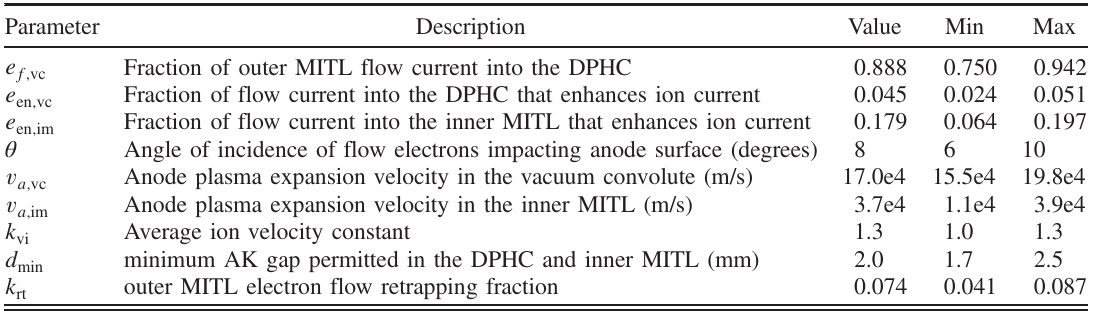
TABLE III. Current-loss-model parameter values obtained from the loss model swarm optimization.